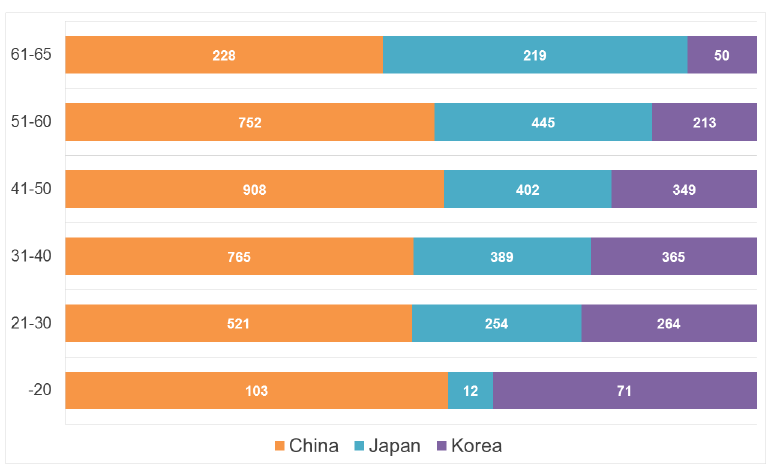
Fig 1. Comparative Age Structures in China, Japan, and Korea. 10-year age groups in which “ younger than 20 (-20) ” in Japan includes only those who are 20. Numbers in bars indicate corresponding numbers of observation.